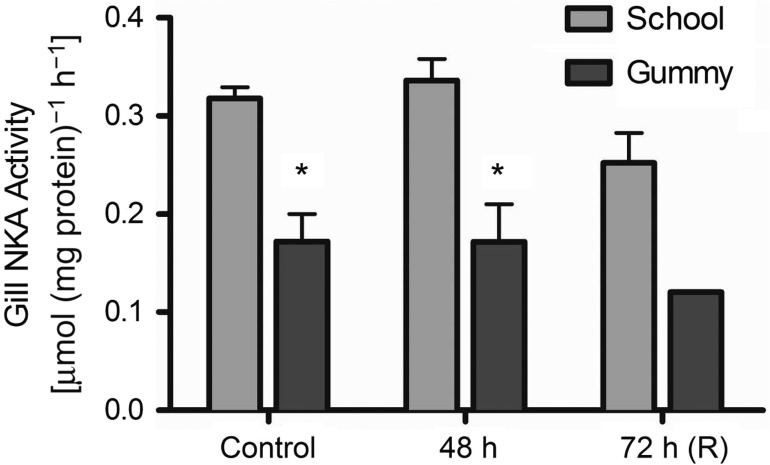
Na+/K+-ATPase (NKA) activity (in
micromoles per milligram of protein per hour; mean
values + SEM) in the gill tissue of school sharks
(Galeorhinus galeus) and gummy sharks (Mustelus
antarcticus). Asterisks indicate a statistically significant
difference between species (P < 0.05;
see Materials and methods for species replication numbers). Recovery (R)
data are not included in the statistical analyses.